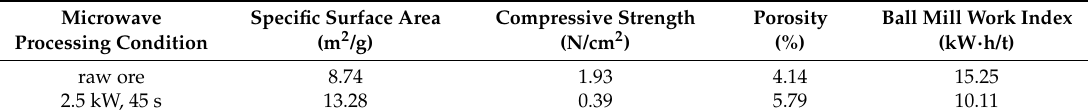
Table 3. Parameters in four properties of raw ore and ore after microwave.